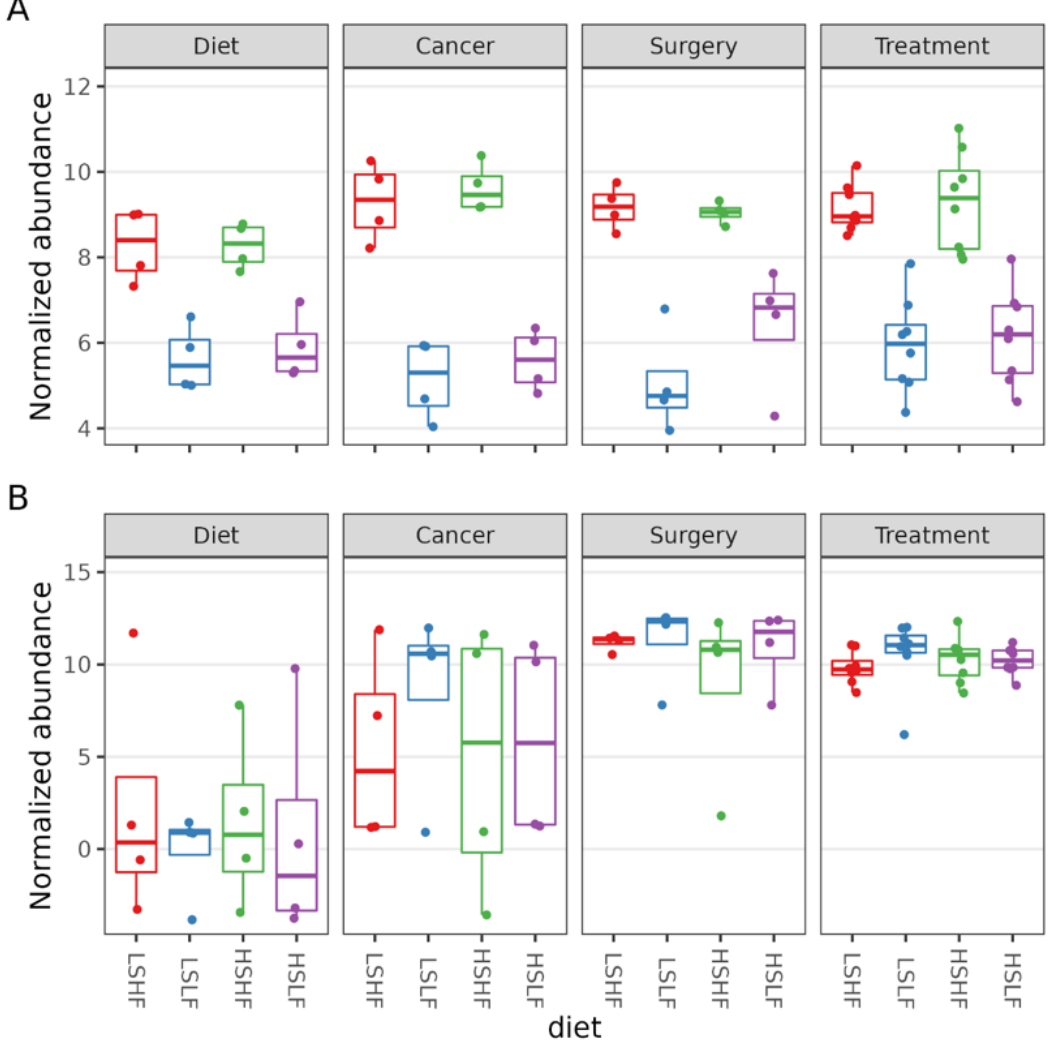
Figure 6. ( A ) Abundance of ASV50 by timepoint and diet; ( B ) abundance of the family Peptostrepto- coccaceae by timepoint and diet.